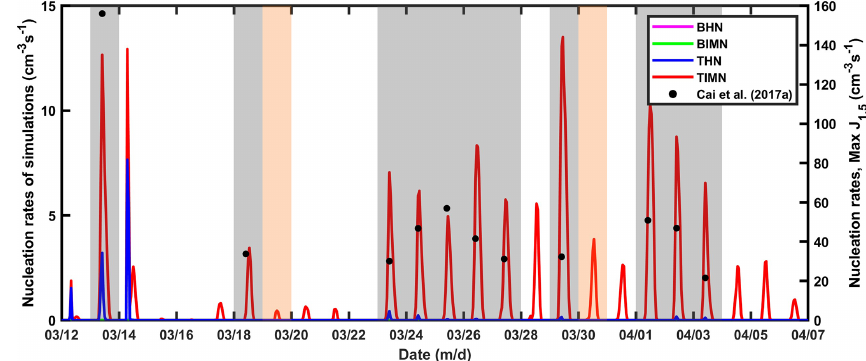
Figure 7. Time series of nucleation rates simulated on the basis of BHN, BIMN, THN, and TIMN schemes during the measurement period and the measured particle nucleation rates of 1.5nm particles (Max J 1 . 5 ) reported in Cai et al. (2017b). The identified NPF days and undefined days are shaded with a grey and orange background, respectively.